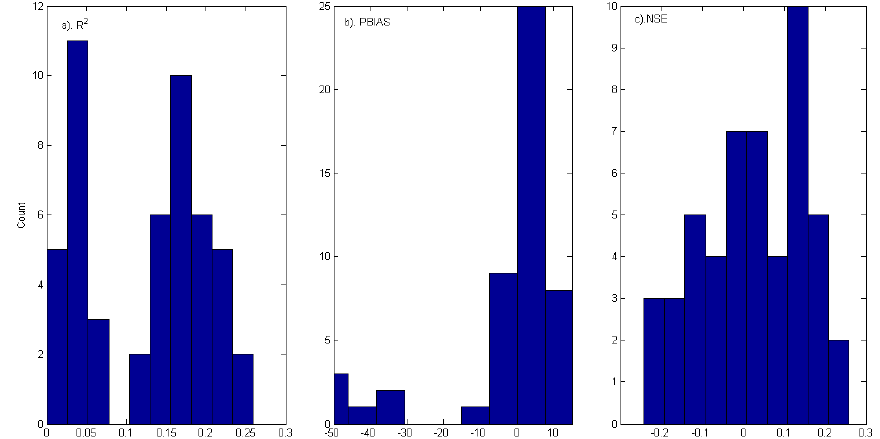
Figure 9. R 2 , PBIAS, and NSE of 50 “random hindcast” runs of k-nearest neighbor (KNN) model.